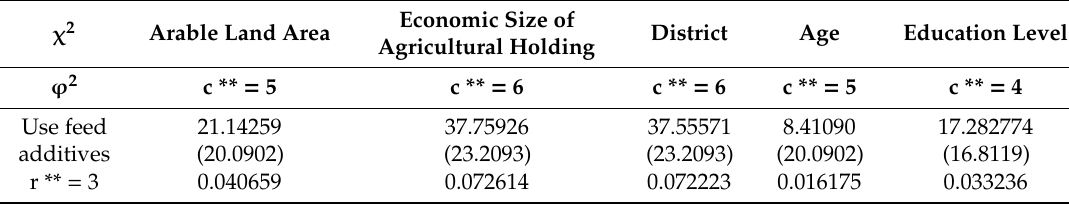
Figure 4. Graphical presentation of the results of the correspondence analysis between the declarations of sharing nitrogen fertilizer doses with the researched characteristics of farmers and farms. Source: own study based on questionnaire surveys ( n = 1034). Table 6. Statistics values χ 2 , critical values χ 2 α = 0.01 * (in parentheses) and mean square contingency ϕ 2 for the following features: use feed additives, arable land area, economics size of agriculture holding, and